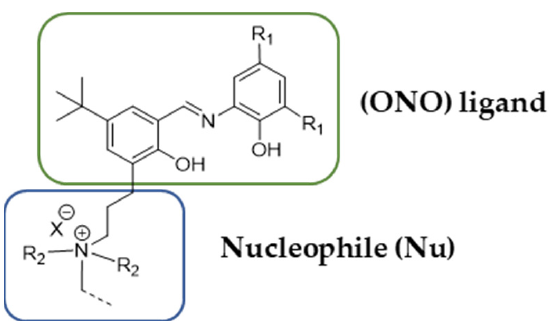
Figure 3. General structure of (ONONu) ligands.